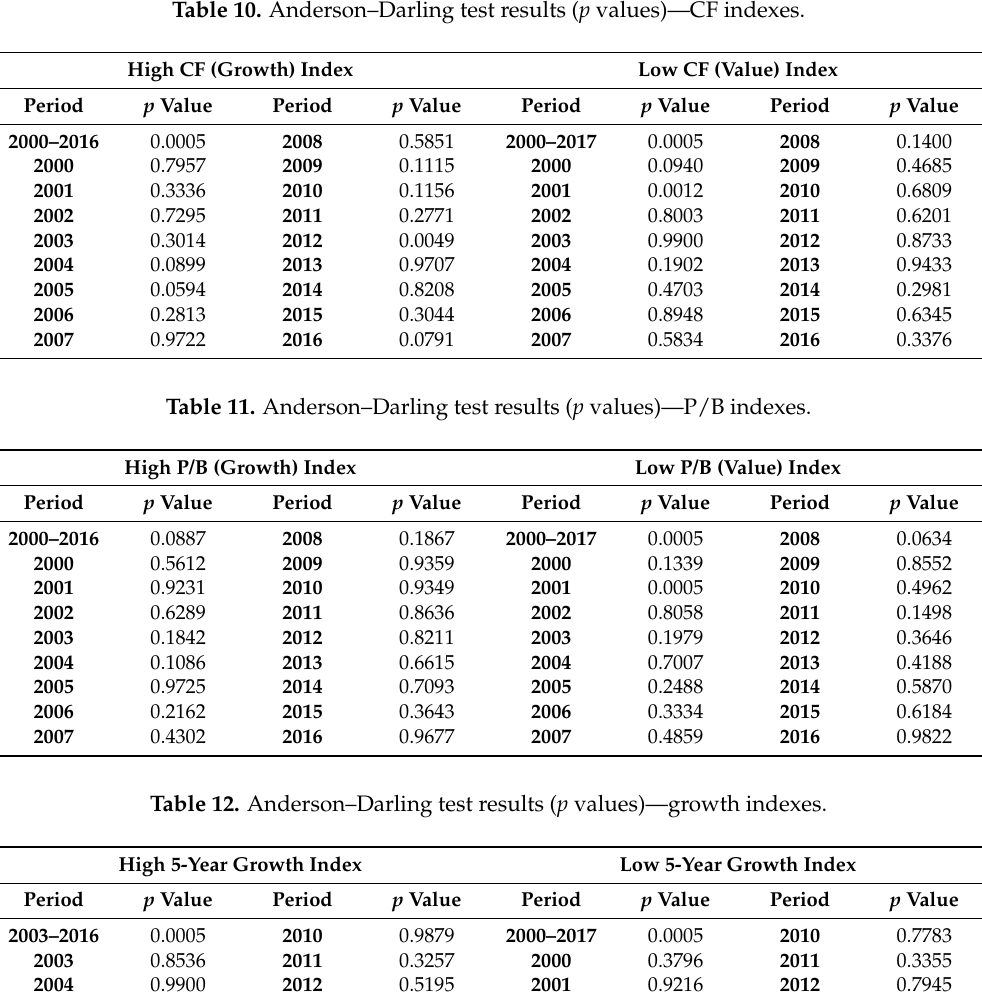
Table 10. Anderson–Darling test results ( p values)—CF indexes.